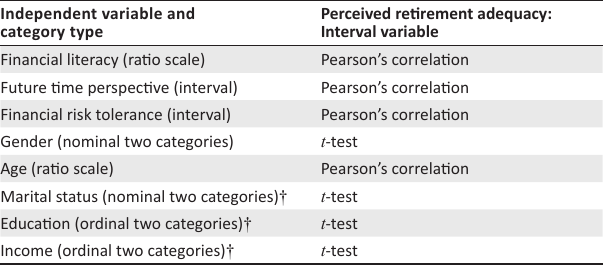
TABLE 1: Statistical